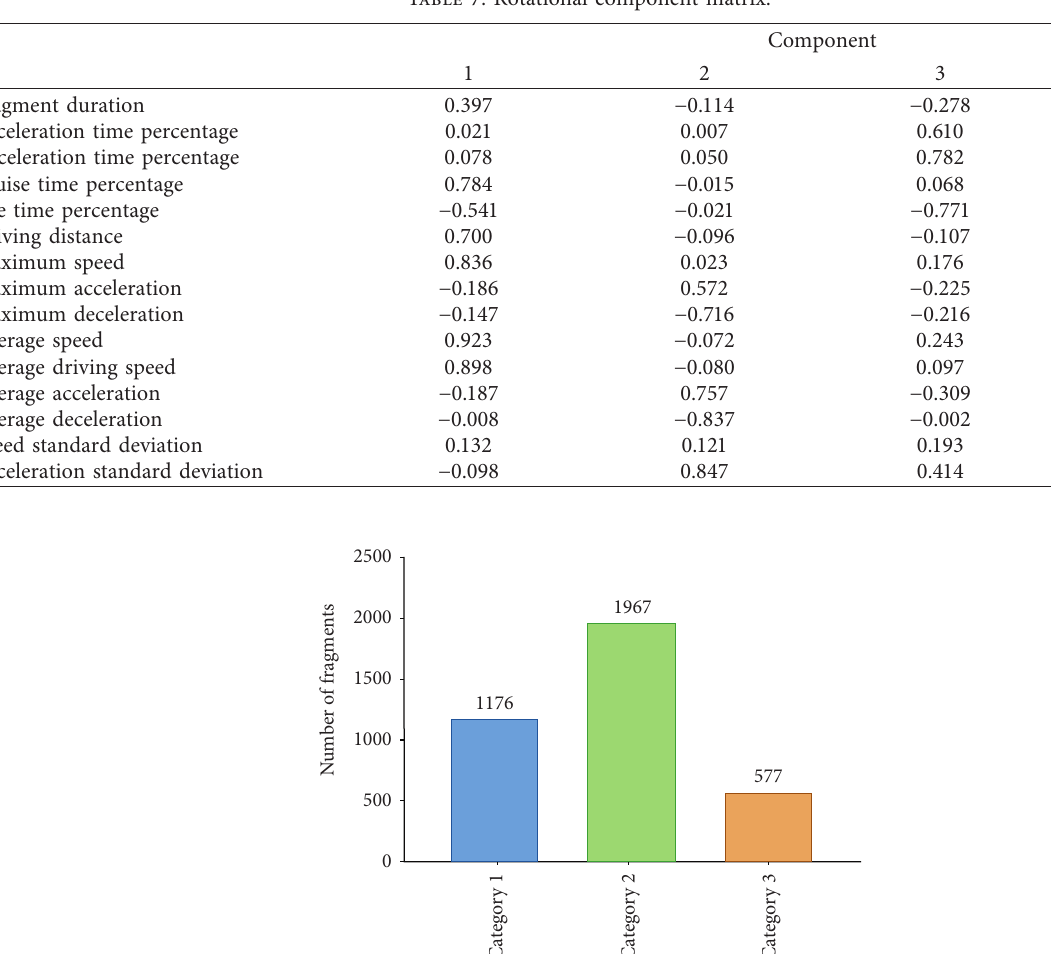
Table 7: Rotational component matrix.